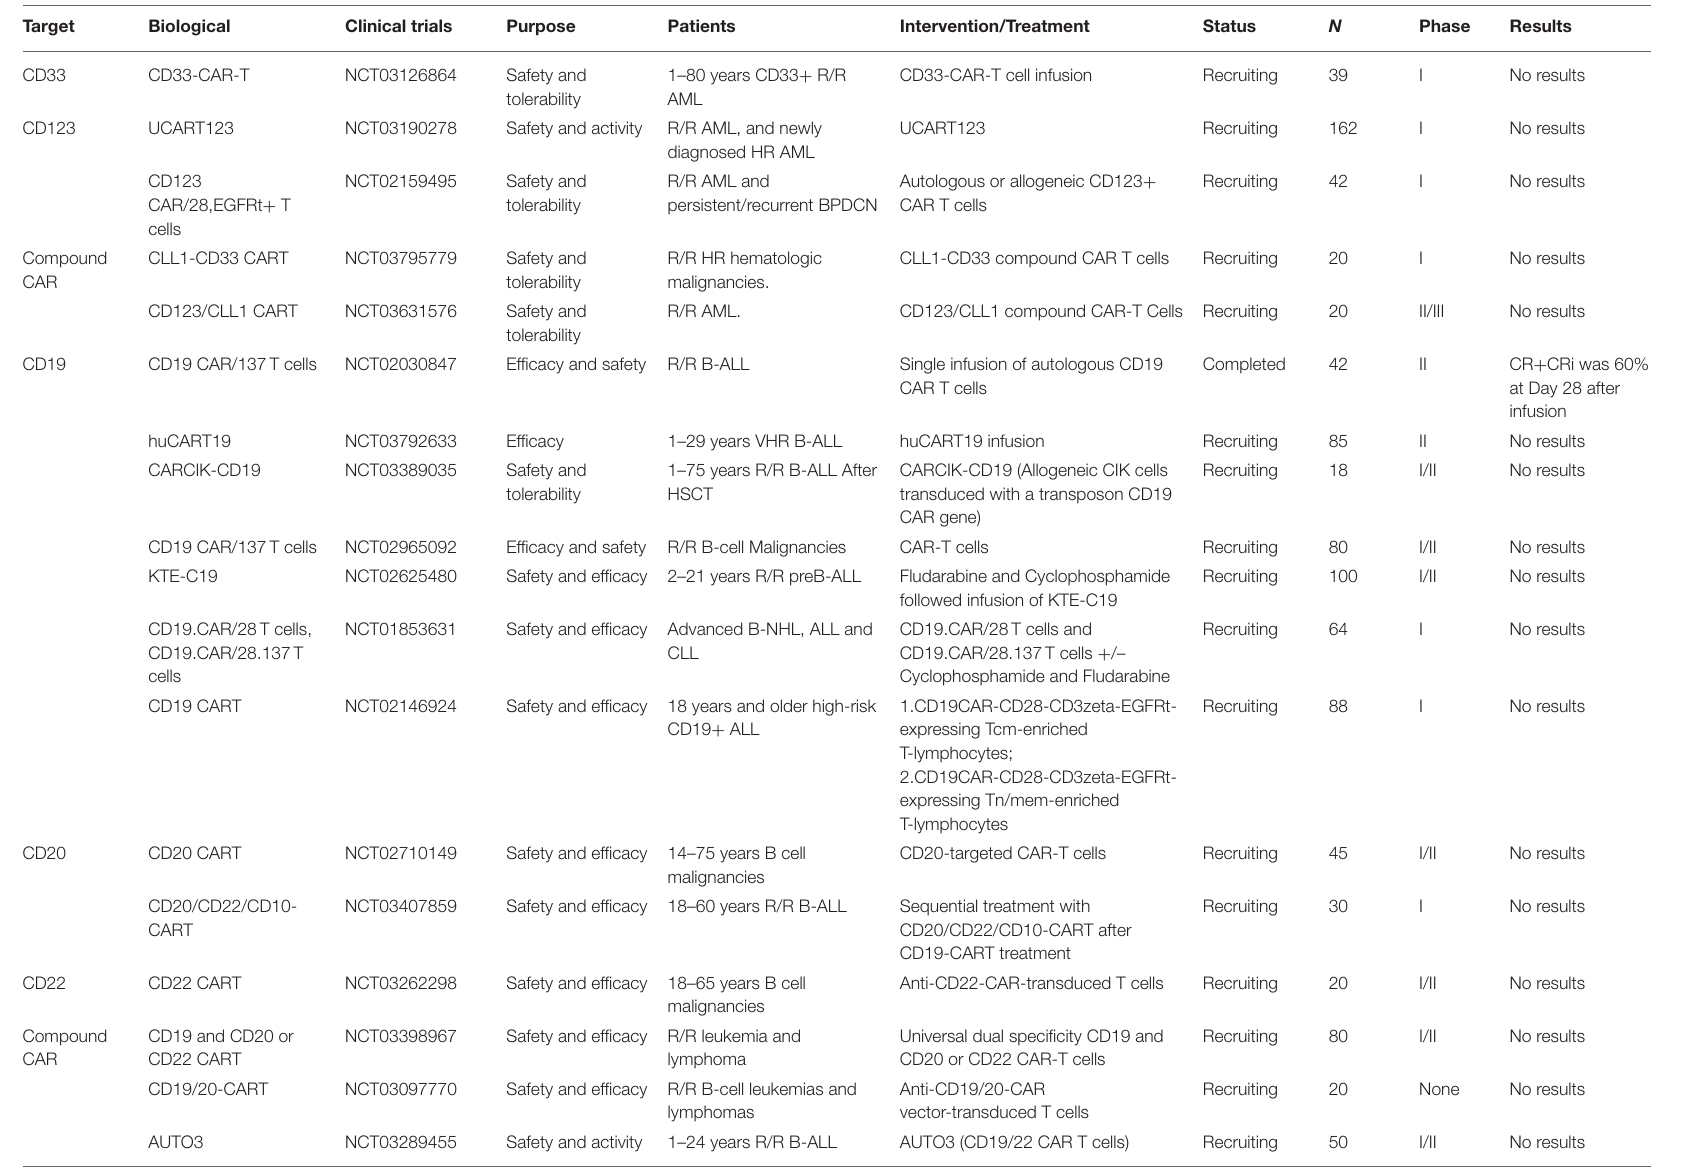
TABLE 4 | Selected completed or ongoing trials of CAR cell therapy for AML and